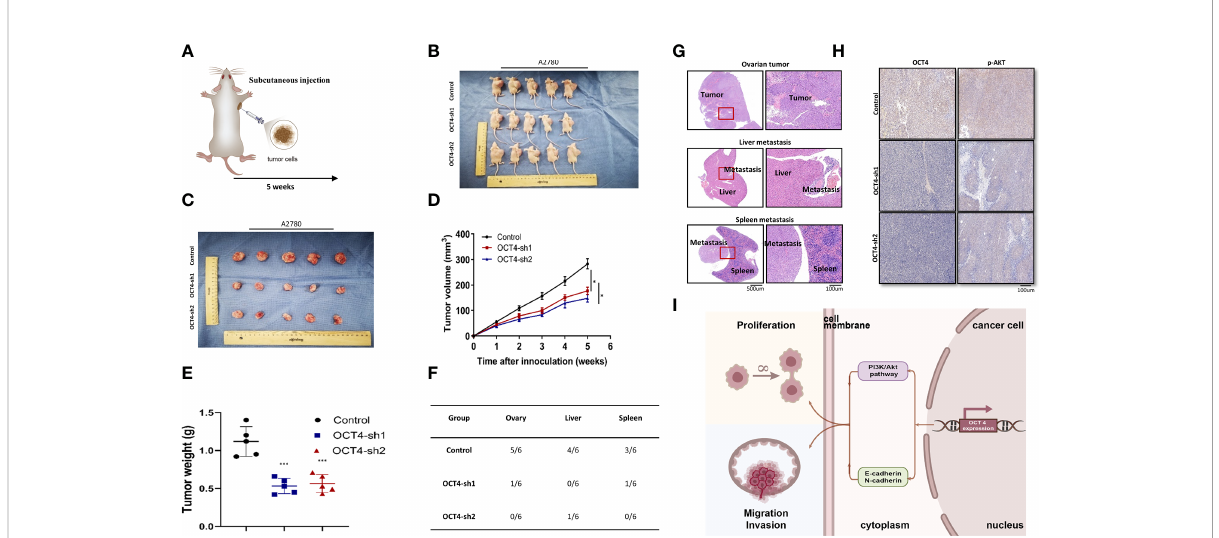
FIGURE 7 The effect of OCT4 knockdown on the proliferation and metastasis of OC in vivo. (A) The subcutaneous injection model of nude mice. (B, C) Size of tumor-bearing nude mice in different groups. (D) Tumor volume was measured weekly after injecting tumor cells. (E) Quanti fi cation of tumor weight. (F) Analysis of the location and number of metastases in tumor-bearing mice of different groups. (G) HE staining of ovarian neoplasms and metastatic tissues. (H) IHC assays of OCT4 and p-AKT in mouse tumors. (I) Model diagram showing the role of OCT4 and the PI3K/AKT/mTOR pathways as well as the EMT pathways regulating the proliferation and metastasis of OC cells. (Data were expressed as the mean ± SD. Signi fi cance was calculated using Student ’ s t-test. *P<0.05,